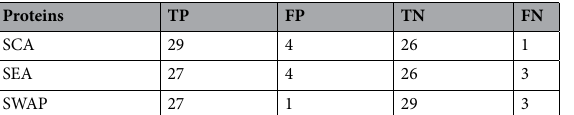
Table 2. Number of true and false result in SCA-ELISA in comparison with SEA and SWAP. SCA; schistosomula crude antigen, SEA; soluble egg antigen, SWAP; soluble worm antigenic preparation.